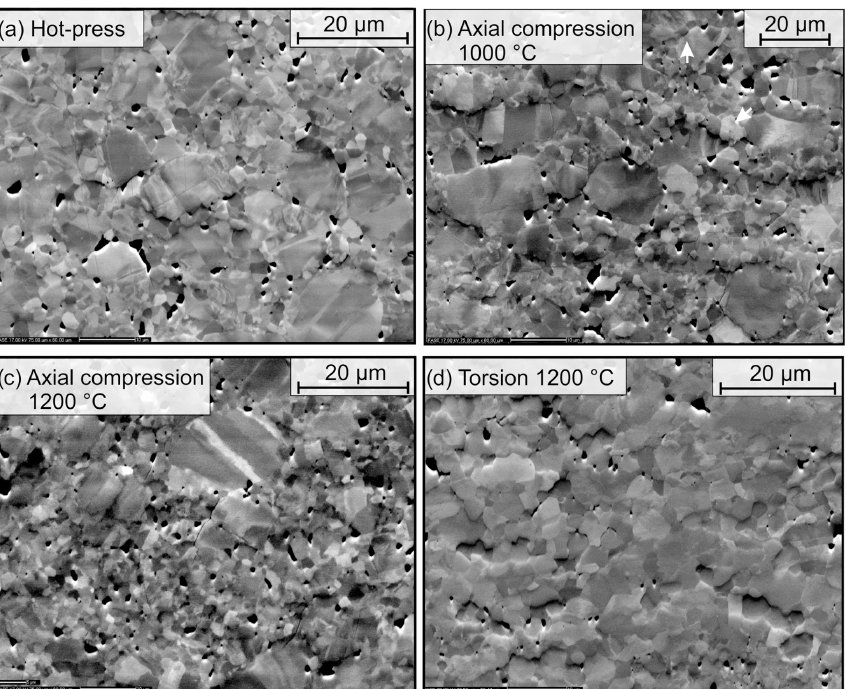
Figure 4. Forward-scattered electron images from scanning electron microscopy (SEM). (a) Typical image from starting material, unde- formed but sintered aggregate by hot pressing at high temperature and pressure (sample CMT-16-7). (b) After axial compression at 1000 ◦ C and for 7.3% of finite strain (CMT-17-2). (c) After axial compression at 1200 ◦ C and for 8.6% of finite strain (CMT-16-9). (d) After torsion at 1200 ◦ C and for 2.05% of equivalent strain (PI0546). Dark areas are pluck-outs from polishing and residual pores from the hot-press step (see main text for